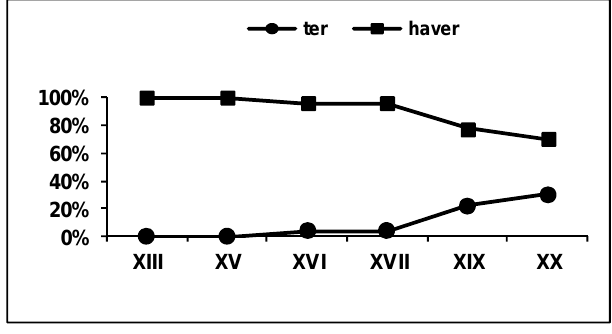
Many authors class existential and locative sentences together.